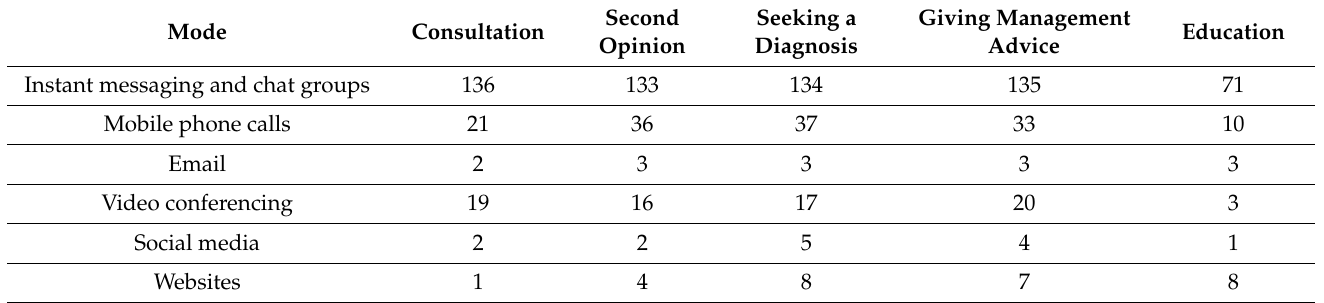
Table 1. Use and mode of telemedicine services ( n = 137).